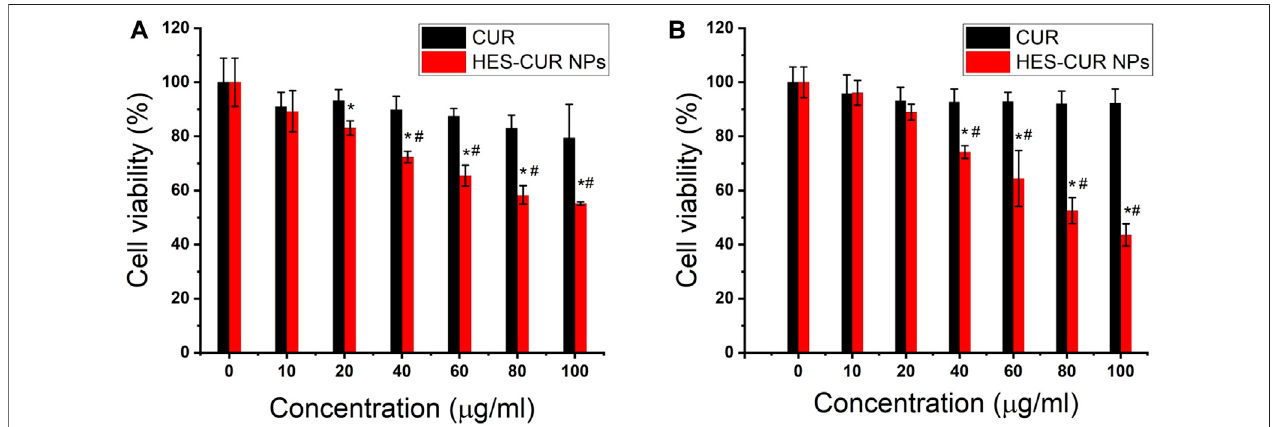
FIGURE 3 | Effects of CUR and HES-CUR NPs on the viability of HepG2 cells incubated for 48 h. (A) CCK-8 assay and (B) cell counting. Data were expressed as mean ± SD, and the experiments were repeated thrice. * p < 0.05, compared to the control; # p < 0.05, comparisons of cell viability between CUR and HES-CUR NPs at the same concentration of